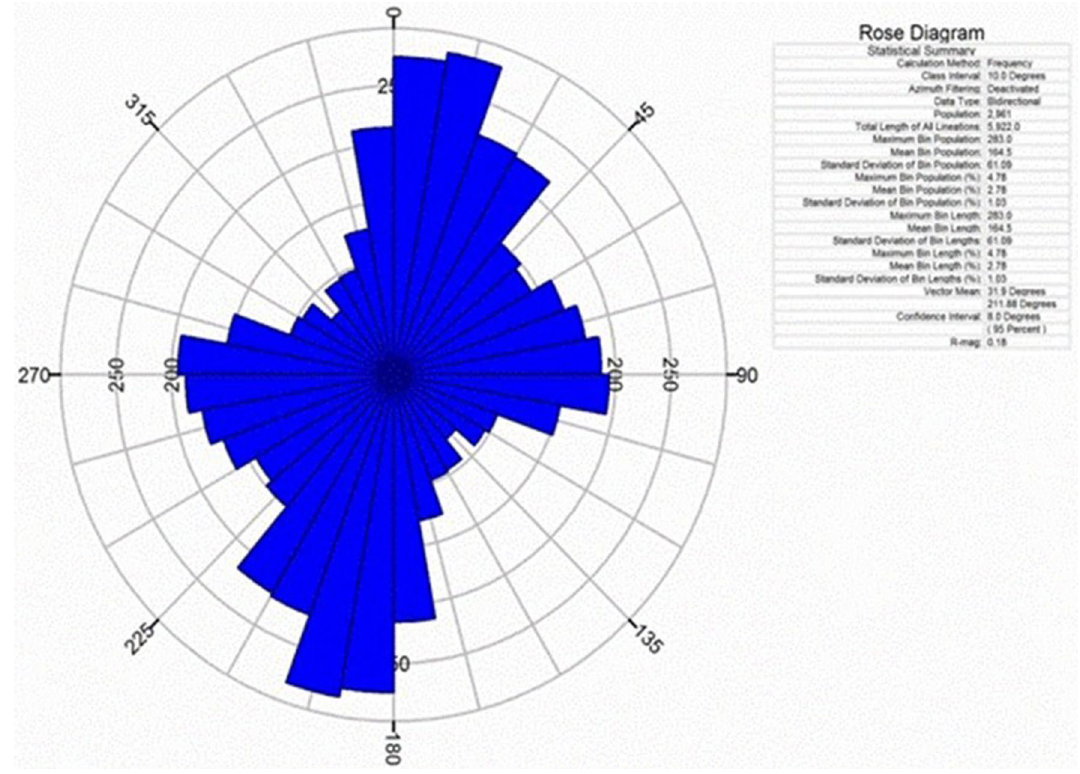
Fig. 5 Rose diagram showing fracture orientation of the study